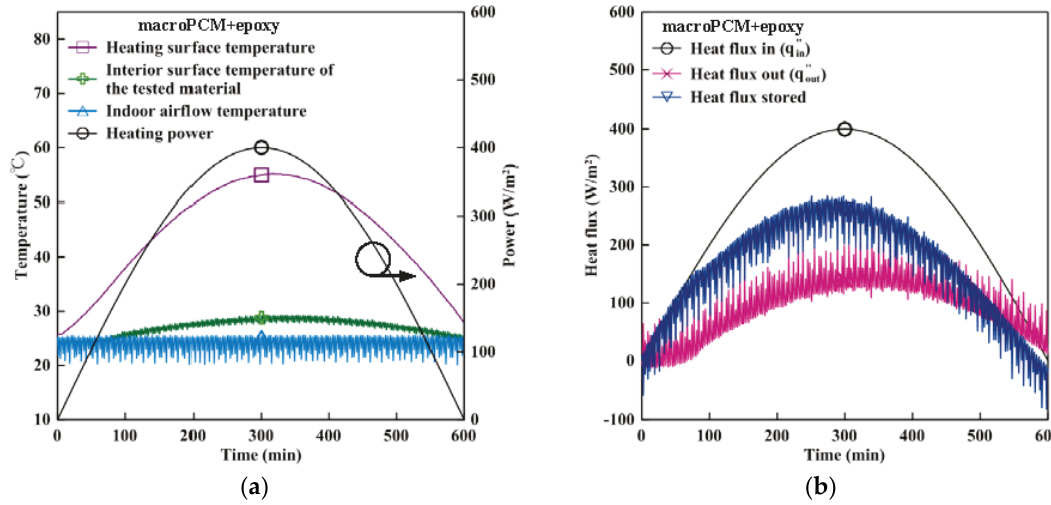
Figure 7. Heat transfer behavior of macroPCM + epoxy ( G s,o = 400 W/m 2 ): ( a ) Temperature changes with time; ( b ) Heat flux changes with time.